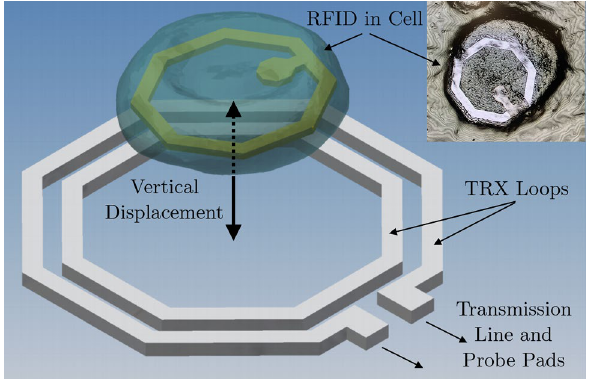
Figure 1. Cell containing intracellular RFID aligned within transceiver antenna loops for RFID detection and identification. The transceiver antennas are connected to a transmission line and probe pads used for electrical measurements. The insert shows an optical image of the RFID in a cell taken with a Keyence VK-X Series 3D Laser Scanning Confocal